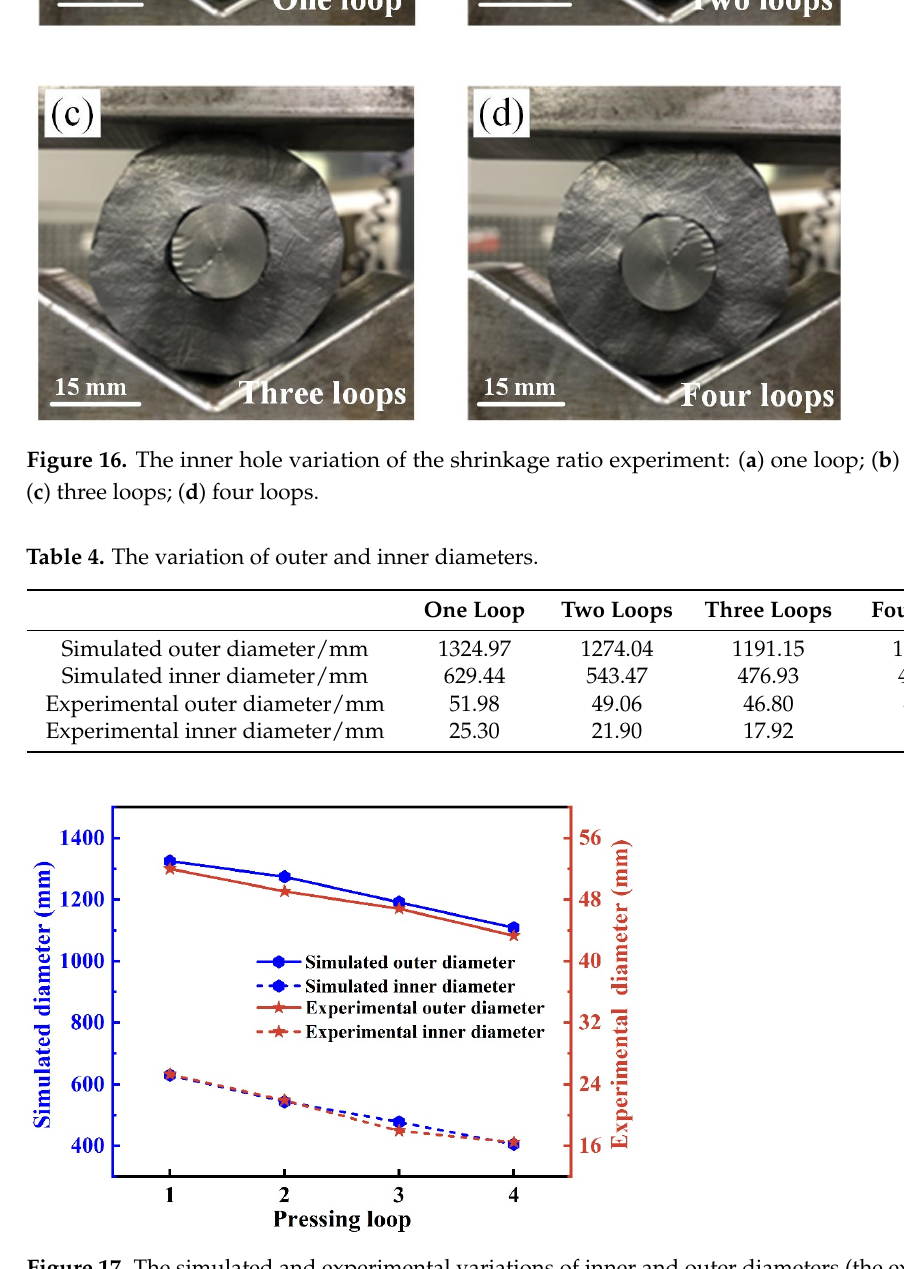
Table 4. The variation of outer and inner diameters.